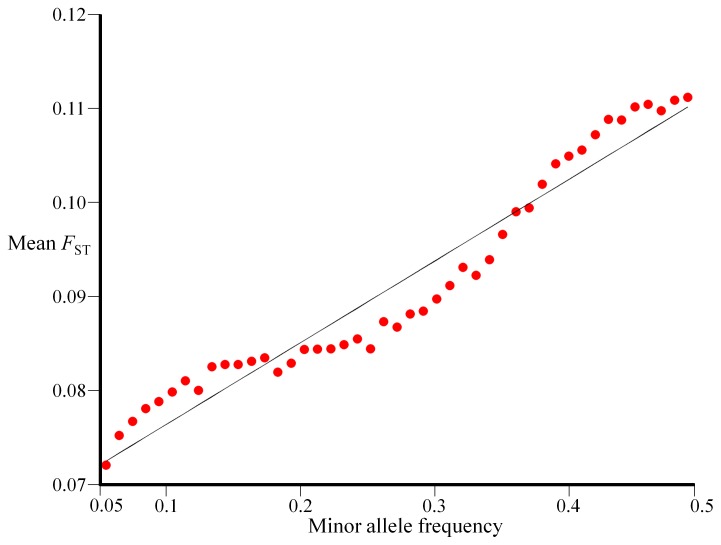
Correlating MAF with F
ST.The mean F
ST plotted for all MAF groups (dots), excluding the rarest ones (MAF >0.05), allows us to express the correlation between the two variables using a single linear equation (Eq. 4).